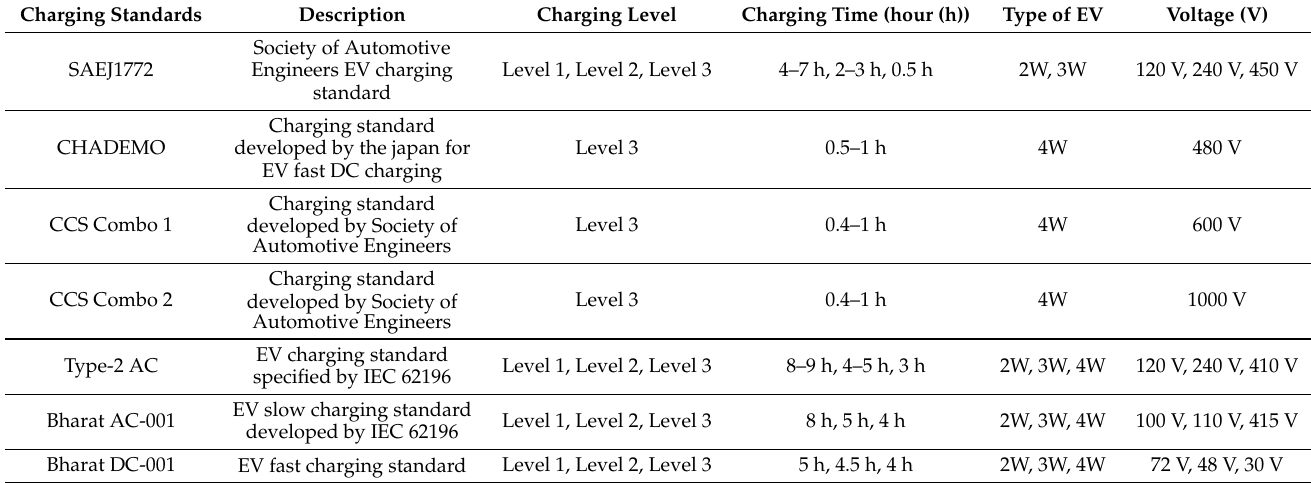
Table 3. Comparative analysis of various EV charging standards based on the charging level, charging time, voltage, and types of vehicle